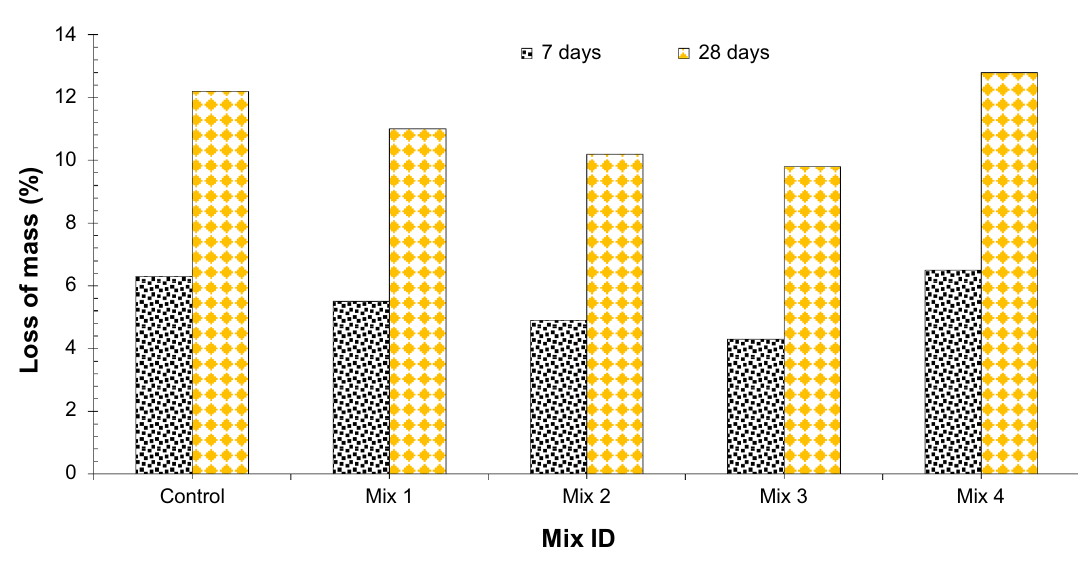
Figure 12. Water absorption of concrete at 7 and 28 days of curing.